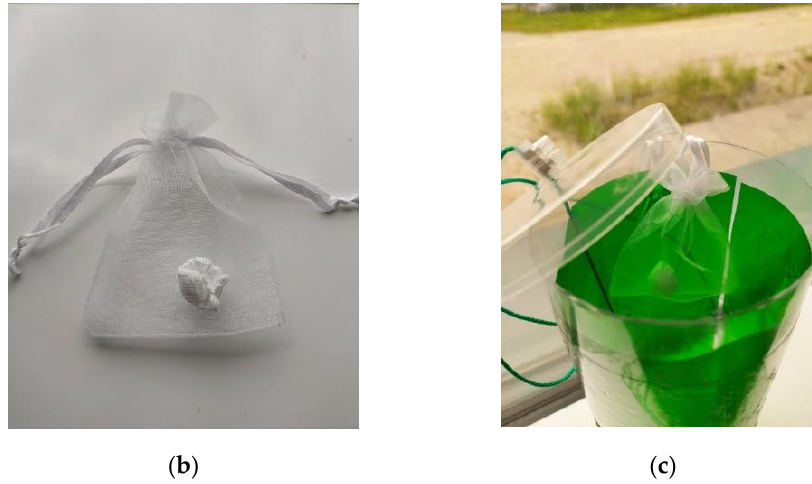
Figure 1. Green cylindric sticky trap used in this study ( a ); Nanofiber material inside a voile bag ( b ); voile bag enclosed in the trap ( c ). voile bag enclosed in the trap ( c